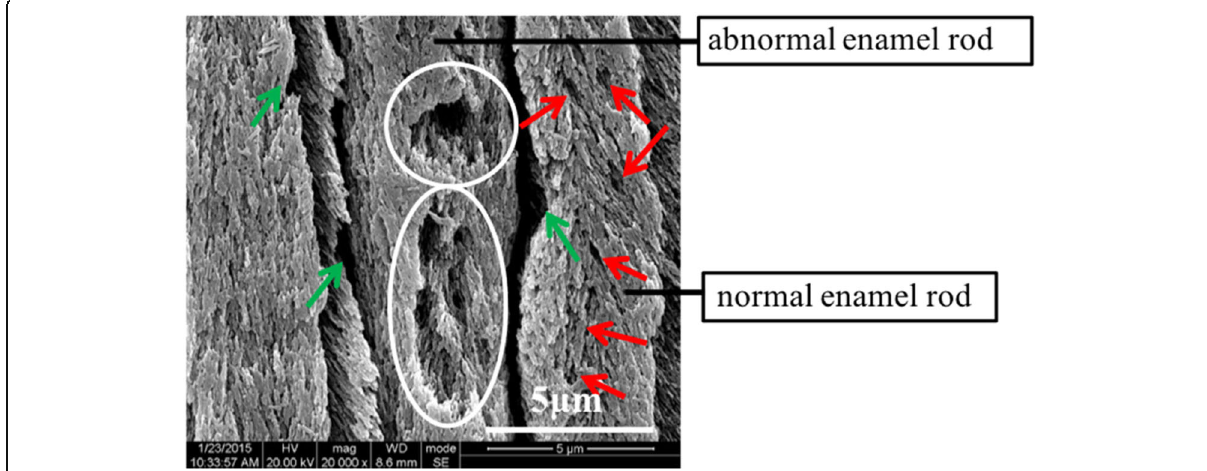
Fig. 7 SEM image of normal and abnormal enamel rods in the outer layer of the dental fluorosis enamel. The microstructure is viewed under ×20,000 magnification after etching with 37% phosphoric acid for 30 s. Green arrows show the broadened gaps between the enamel rods, while white circles show the pores. Red arrows indicate loosely arranged crystals in the enamel rods with increasing crystal clearance and